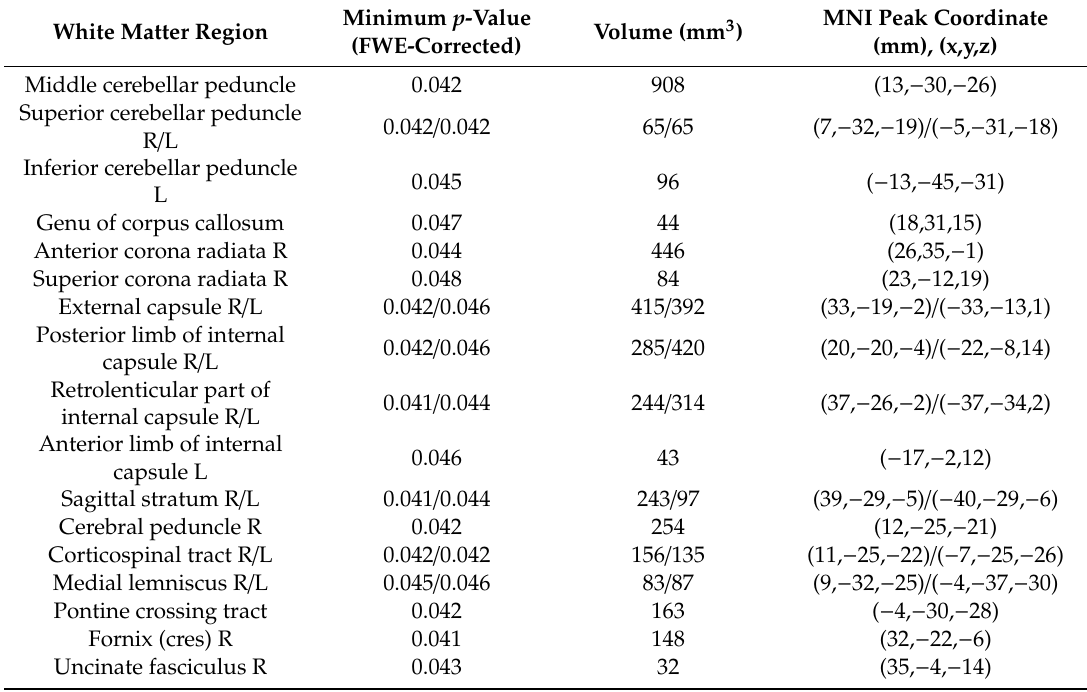
FWE = Family-wise error; L = left; R = right. The column volume represents the volume from the atlas region with significant results. No regions with a volume equal or lower than 30 mm 3 were included in this table.